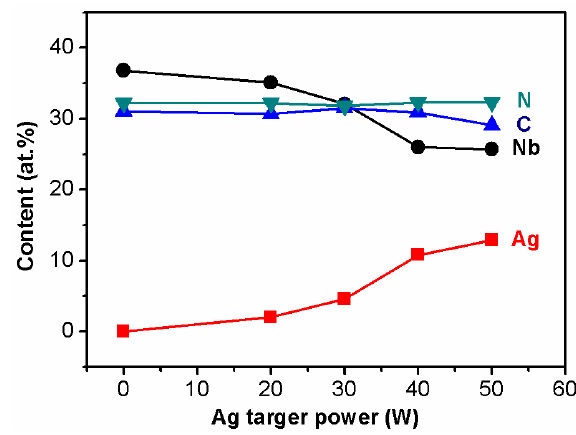
Figure 1. The chemical compositions of NbCN-Ag composite films.